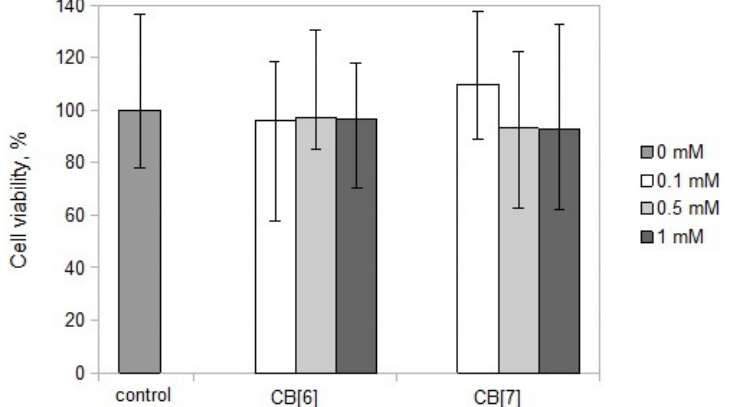
Figure 1. Viability of peripheral blood mononuclear cells (PBMCs) with or without cucurbit[n]uril (CB[n]) at di ff erent concentrations. Data are presented as the median with interquartile range. Table 1. Relative number of cells in di ff erent phases of the cell cycle during the spontaneous proliferative activity of PBMCs cultured for 72 h in the presence of various concentrations of CB[n]. Data are presented as the median with interquartile range.